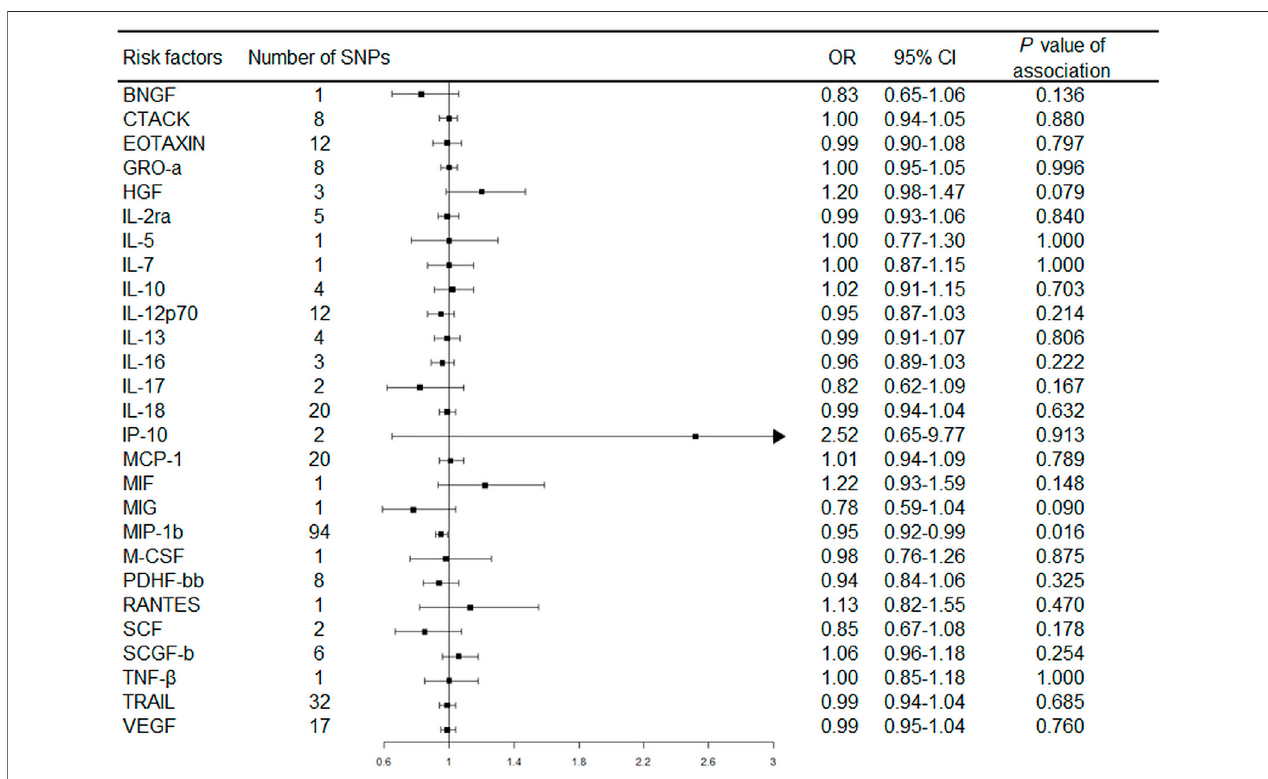
FIGURE 2 | Forest plot of Mendelian randomization analysis for the associations between circulating cytokines with rheumatoid arthritis risk. Abbreviations: CI, con fi dence interval; OR, odds ratio; SNP, single nucleotide polymorphism.